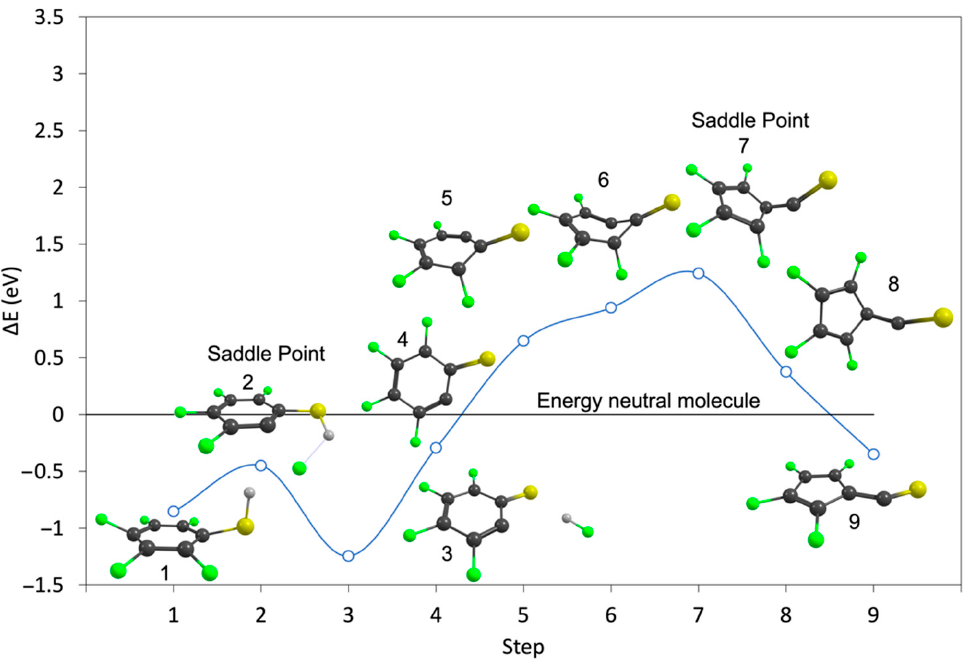
Figure 3. Minimum energy path for the direct HF loss (steps 1–4) and the formation of the 5-membered ring C 5 F 4 –CS − (steps 4–9) from the anionic ground state of PFTP (step 1) calculated using the NEB-TS method at the B3LYP D3BJ/aug-cc-pVTZ level of theory. Step 4 corresponds to the direct HF loss, i.e., without the rearrangement of the ring. The single point energies (open circles) along the reaction paths are relative to the energy of the neutral parent molecule, which is set to 0 eV (horizontal black line). ZPVEs and thermal energy correction for the neutral molecule were taken into account.